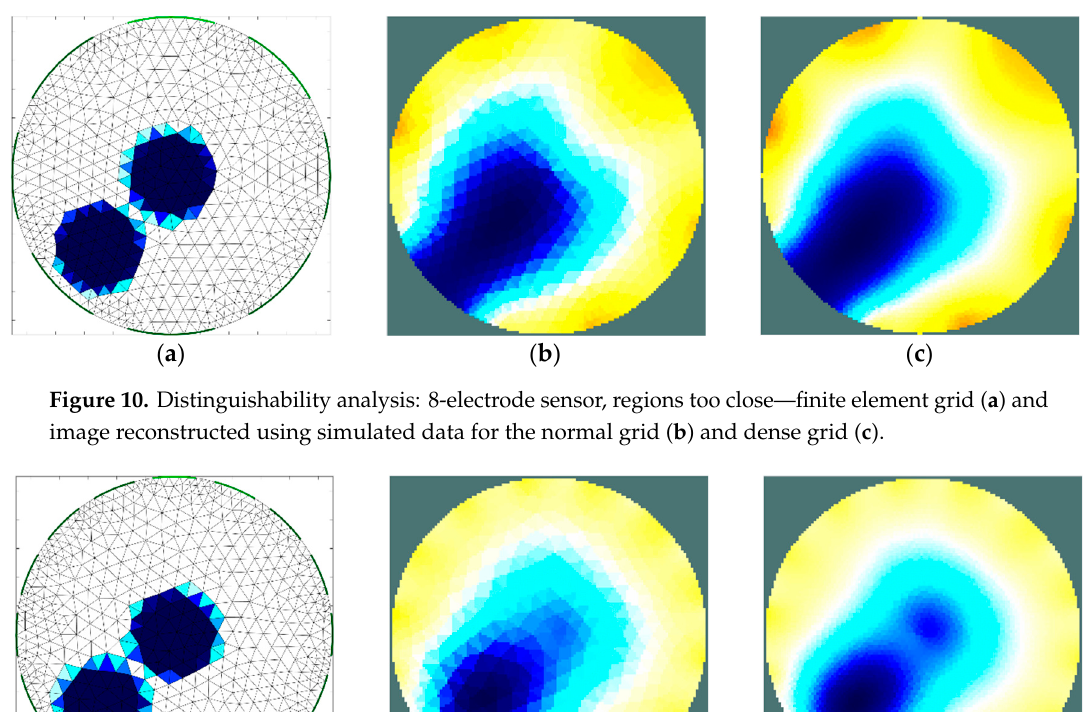
Figure 9. Distinguishability analysis: 16-electrode sensor—finite element grid ( a ) and image reconstructed using simulated data for the normal grid ( b ) and dense grid ( c ).